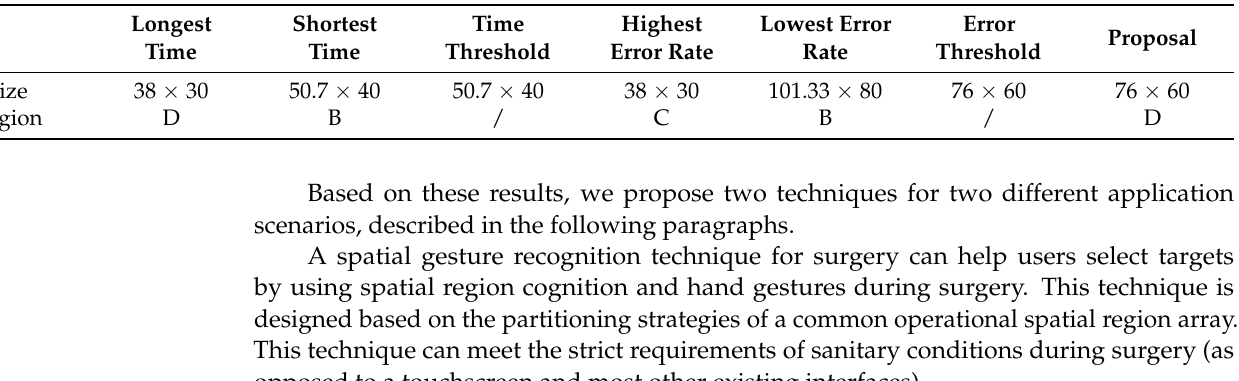
Table 4. Design suggestions for selecting spatial targets under non-visual